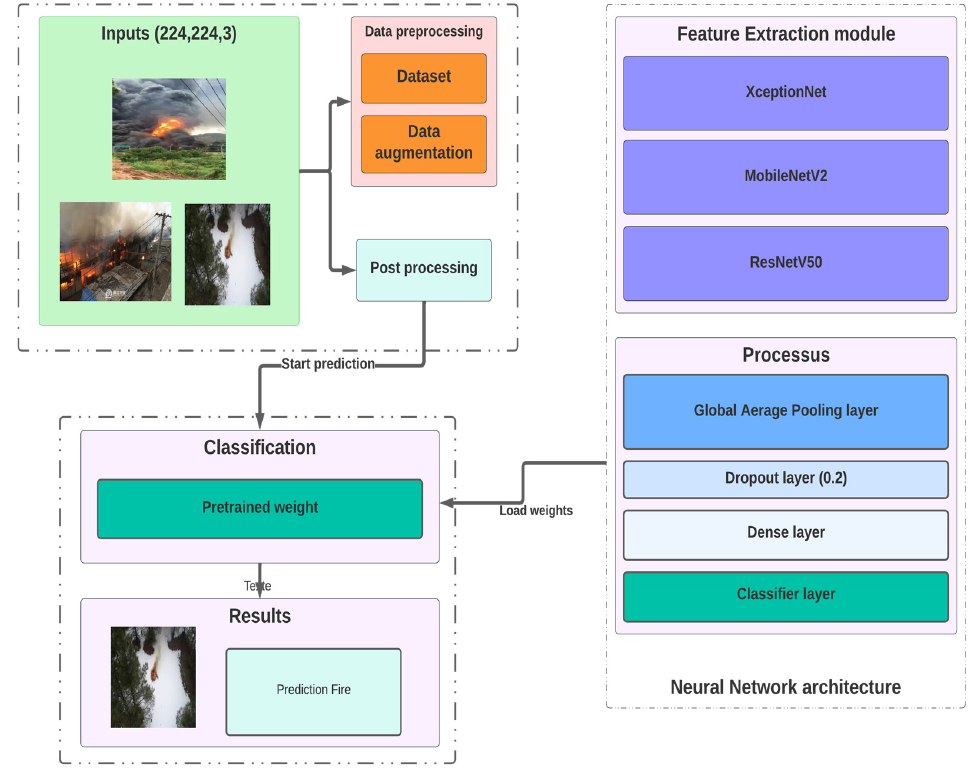
Figure 1. Classifier architecture: the classifier is divided into 3 stages/departments. The first stage is the data processing part, the second department is the neural net architecture, and the final one is the predictor part.